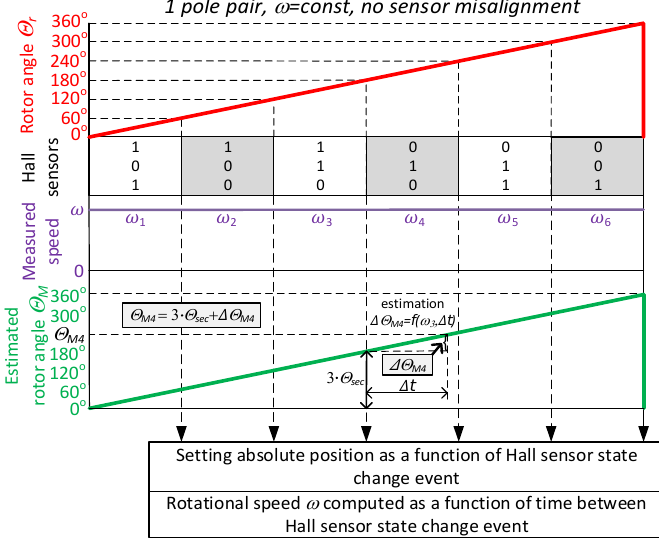
Figure 1. Estimation of the angular position of the BLDC motor based on the change in the Hall sensors ’ state for the correct arrangement of the sensors.